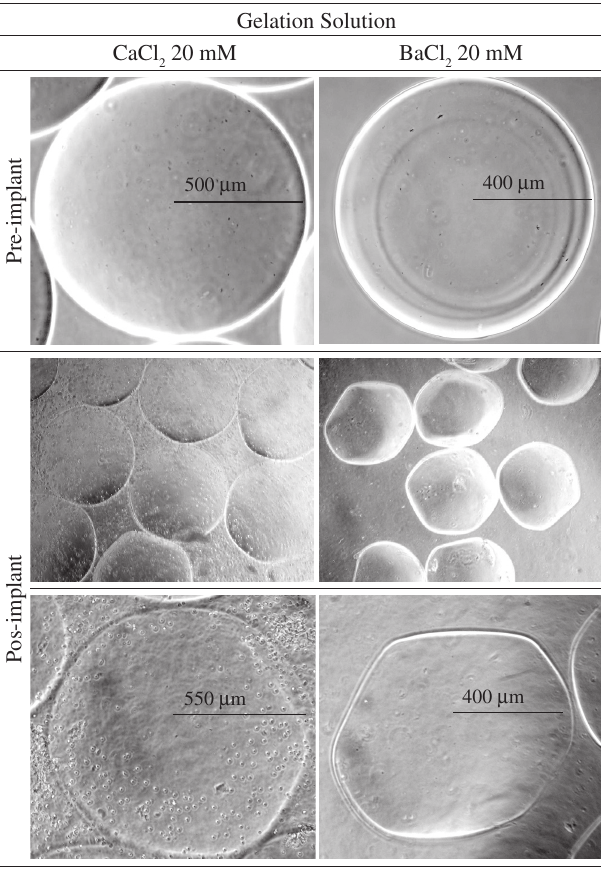
Figure 3. Biodritin ® microcapsules after being subjected to shearing generated by rotation at 133 rpm. a) after 60 minutes of rotation the Biodritin-calcium microcapsules resisted to the impact; and b) After 60 minutes of rotation of the Biodritin-barium it was possible to observe debris among the microcapsules and damaged microcapsules.